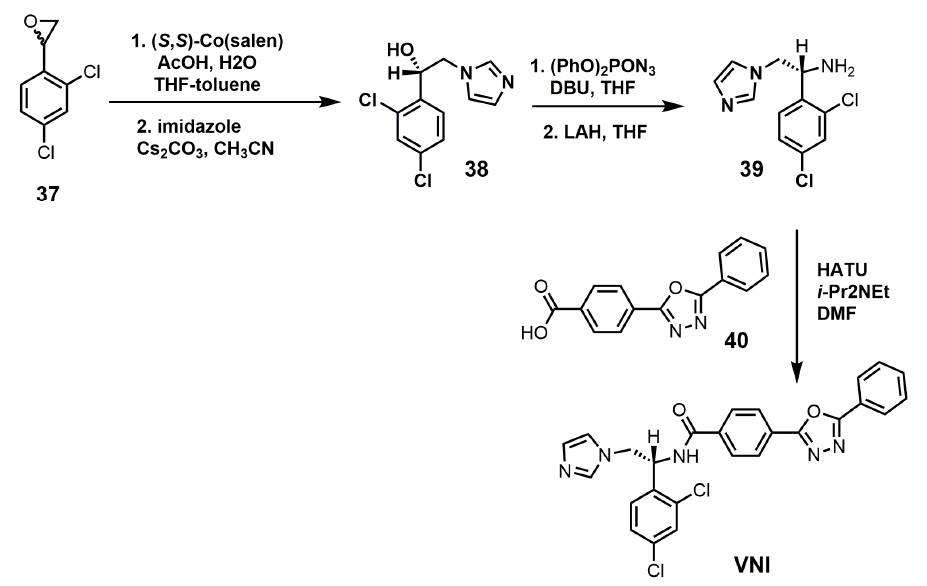
Figure 18. Different C24-alkylation pathways for sterol C24-methyltransferase (24-SMT) substrates (adapted from [4]). Nu: sterol nucleus.